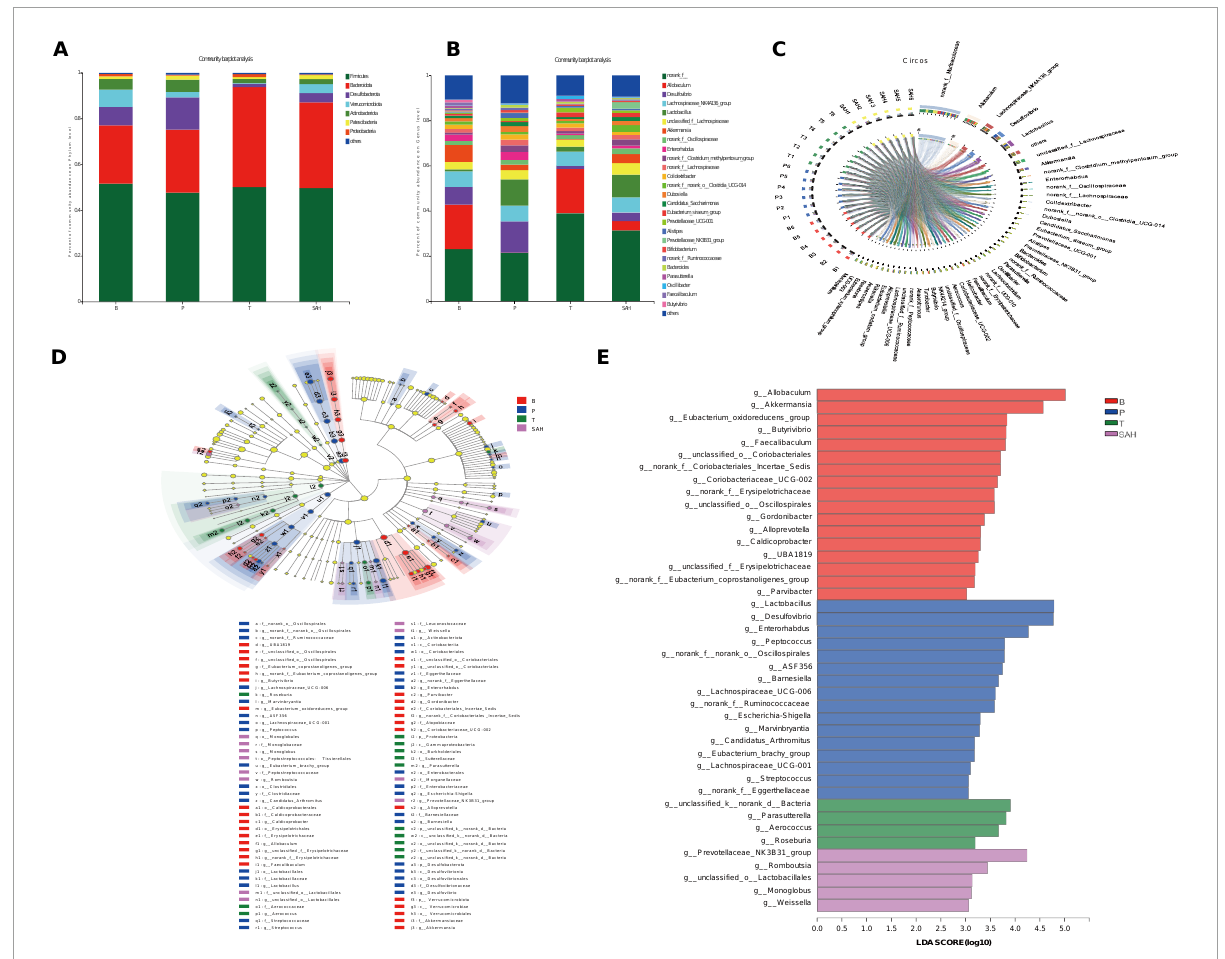
FIGURE7 Sciadonic acid (SA) regulated intestinal flora composition in type 2 diabetes mellitus (T2DM) mice. (A) Percent community abundance diagram on phylum level, (B) percent community abundance diagram on genus level, (C) in Circo’s graphs, the left semicircle represents the genera composition, and the right semicircle indicated the distribution of each genus in the experimental groups, (D) lEfSe multi-level classification tree diagram, and (E) LDA discriminant histogram. Data were presented as the mean ± SD ( n = 6). B, control group; P, diabetic model group; T, (HFD + 200 mg kg – 1 Met); SAH, (HFD + 280 mg kg – 1